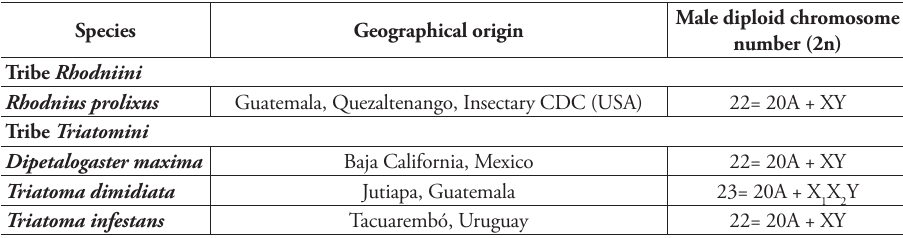
Table 1. Geographical origin and male diploid chromosome number in the four species here analyzed. A =